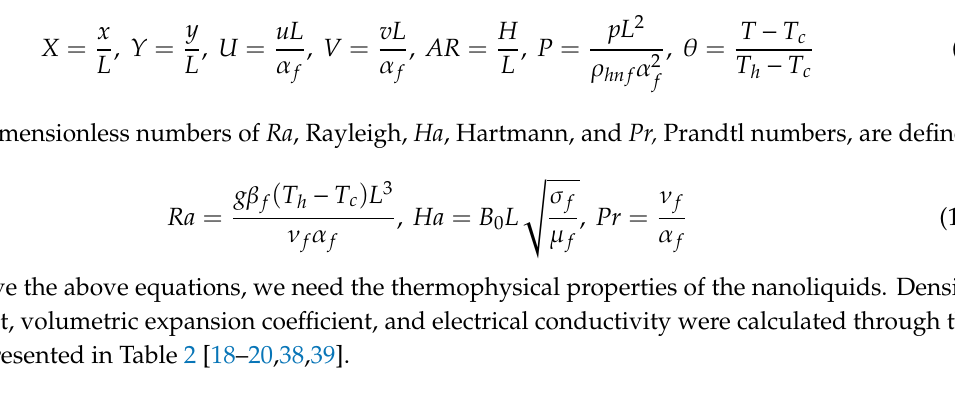
Table 2. Thermophysical properties of the mono and hybrid